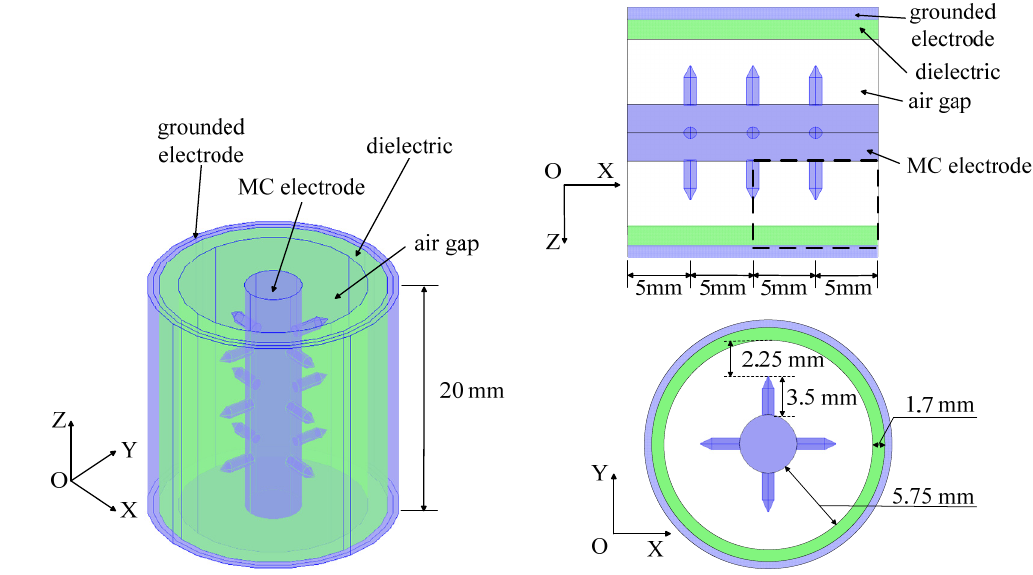
Figure 2. 3-D geometry in the current work (the cross section in the dashed frame is adopted as the simplified 2-D simulation model).